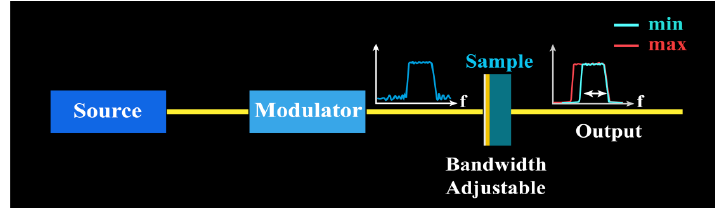
Figure 5. Application of an adjustable filter. Table 1. The performance comparison of different EIT-like metamaterial structures.